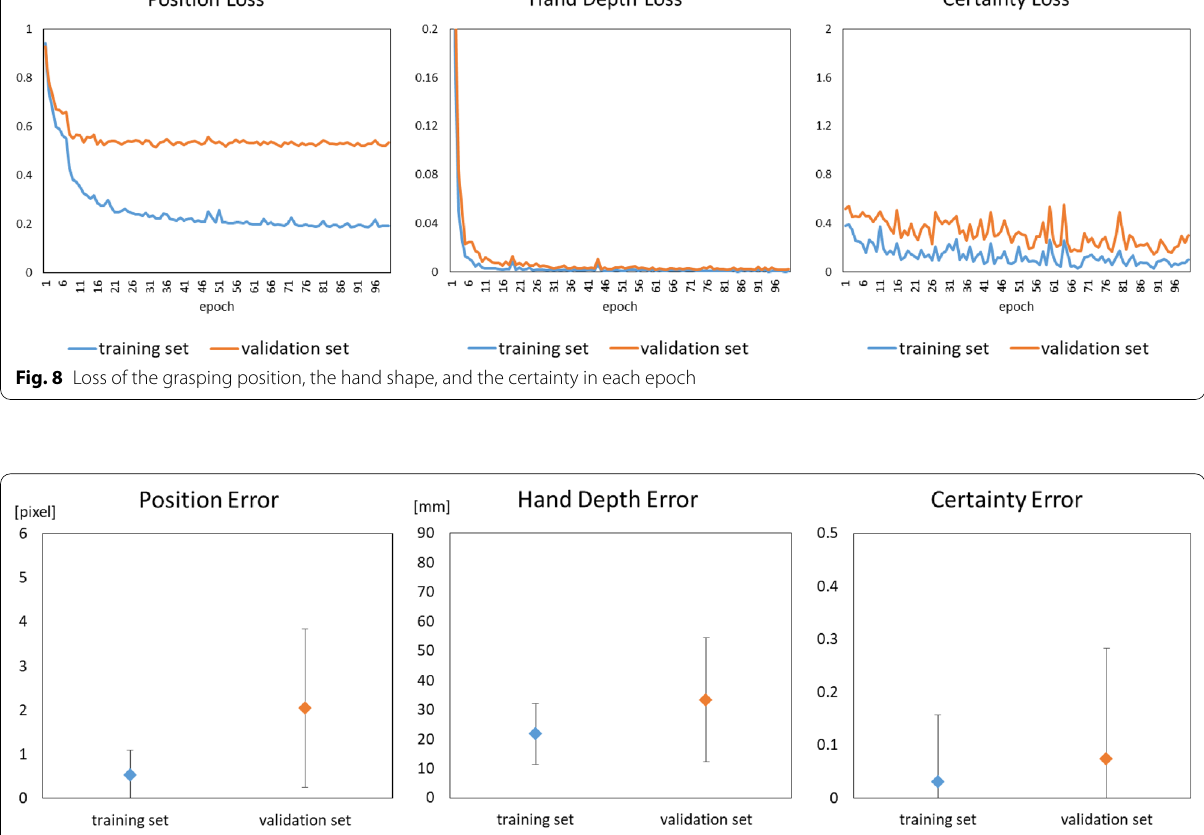
Fig. 9 Mean error and standard deviation per a sample of the grasping position, the hand depth, and the